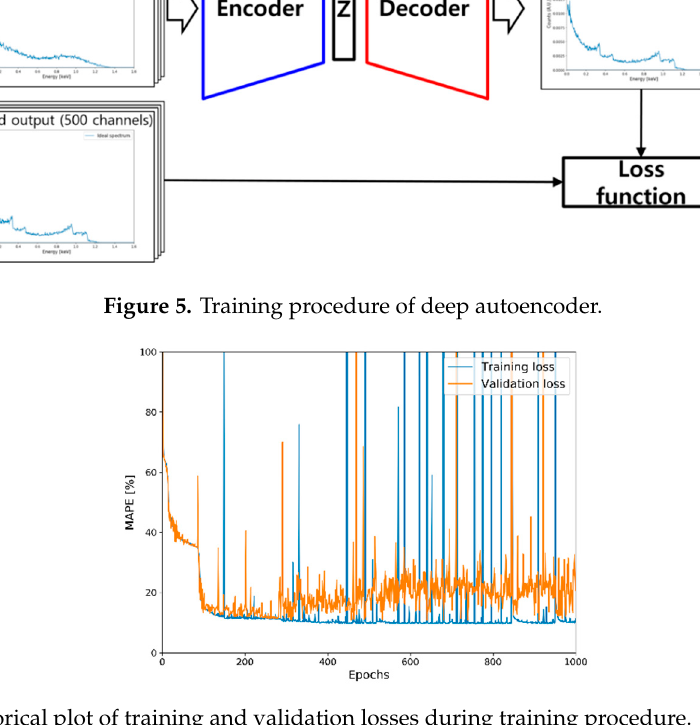
Figure 6. Historical plot of training and validation losses during training procedure. The best model during the epochs was stored with the use of the model checkpoint option and utilized as the final model.